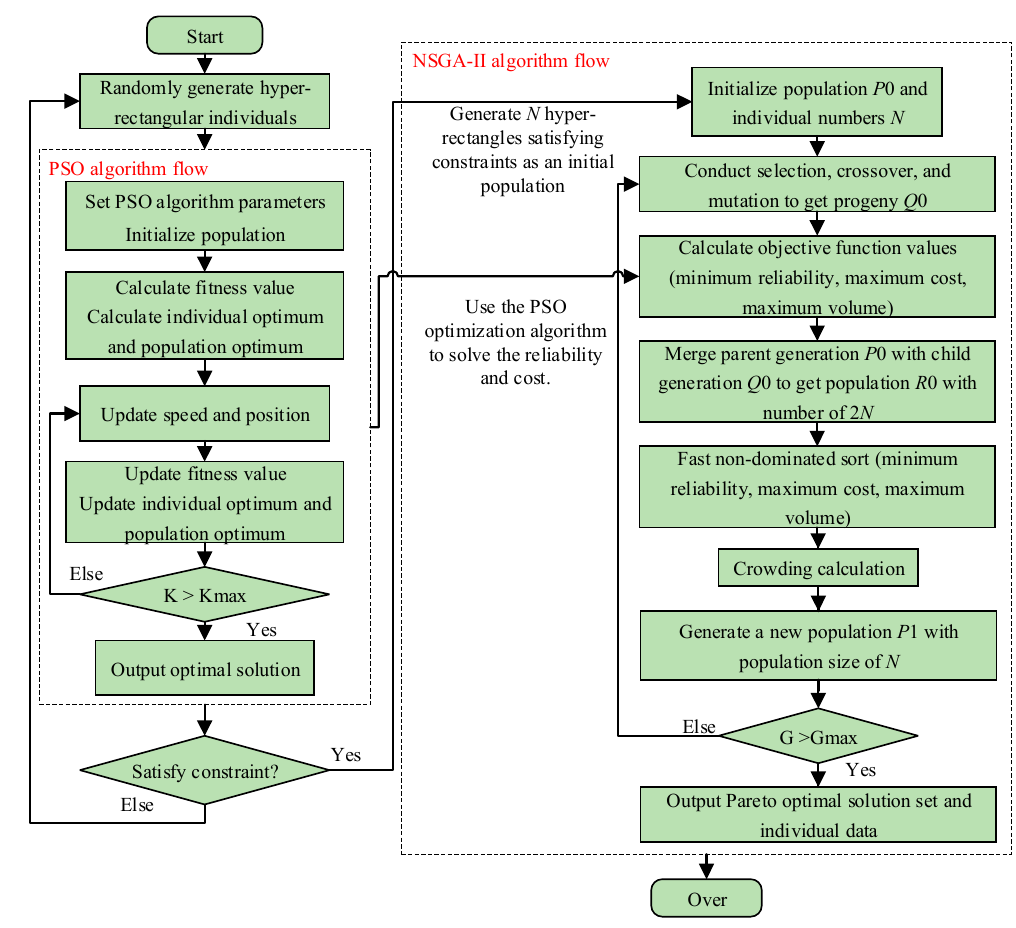
Figure 5. Flowchart of NSGA-II-PSO algorithm.